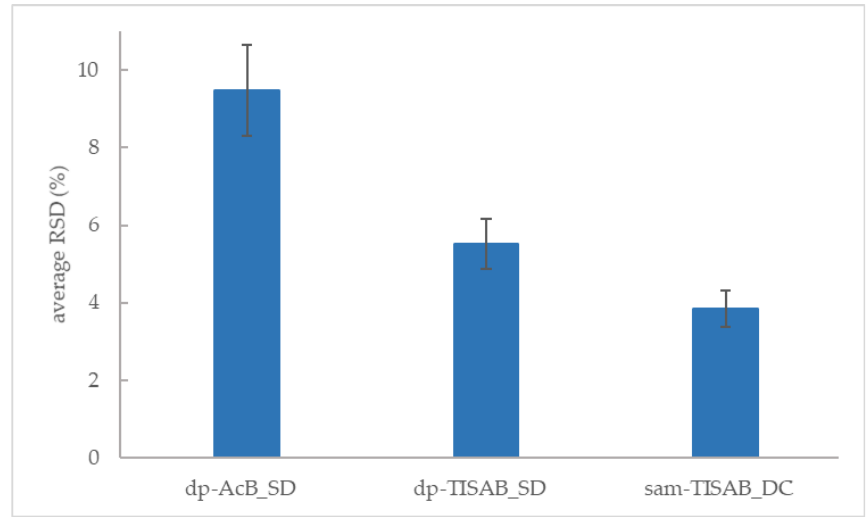
Figure 3. Graphical description of the method’s accuracy expressed using mean values of RSD in fluoride determination in wine samples.